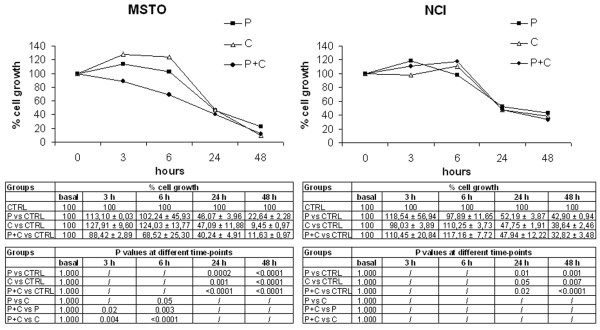
Inhibition of MSTO (left panel) and NCI (right panel) by piroxicam and/or CDDP. MSTO and NCI were treated for the indicated time periods as previously specified. Cell growth was assessed by cell counts and was expressed as percent of control (untreated cells). Experiments were repeated in triplicate and media values were calculated and indicated in the upper table. P values at the different points of the treatments respect to the control and of the combined treatment (P+C) respect to the single drugs treatment were indicated in the lower tables. CTRL = control; P = piroxicam; C = CDDP.